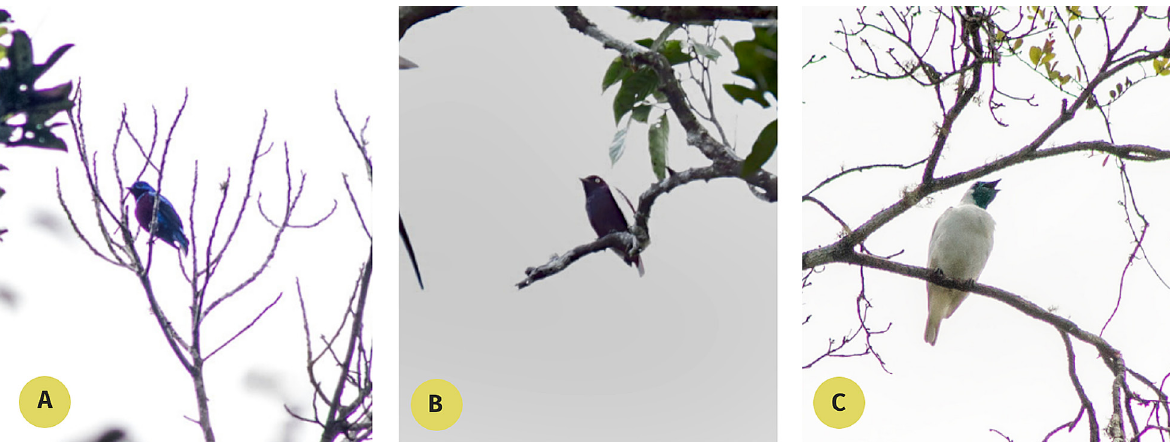
Figure 2. Three species of threatened cotingas in two Atlantic Forest fragments in Bahia, Brazil. A. Cotinga maculata . B. Xypholena atro- purpurea . C. Procnias